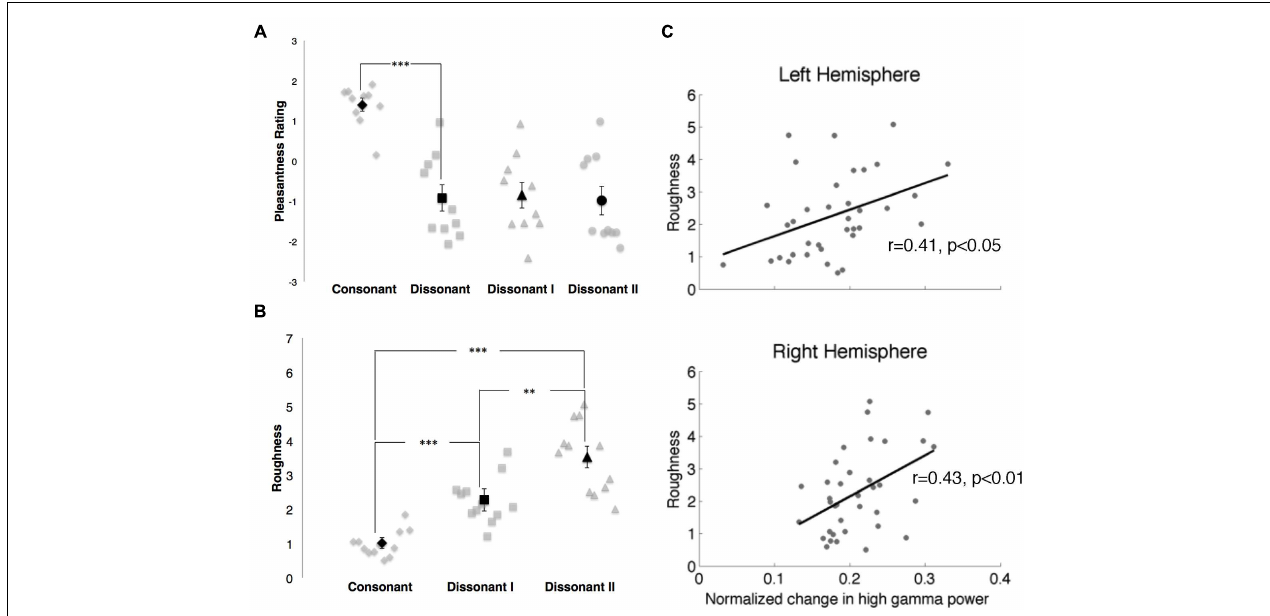
FIGURE 6 | (A) Pleasantness ratings for consonant, dissonant, dissonant I and dissonant II chords as indicated by 10 subjects. Points in gray denote individual subject ratings; points in black denote mean subject ratings. Error bars indicate standard error of the mean ratings. ∗∗∗ p < 0.001 (paired t -test). (B) Roughness measures for consonant, dissonant I and dissonant II chords. Points in gray denote individual chords. Points in black denote mean roughness values. Error bars indicate standard error of the mean roughness value. ∗∗ p < 0.01, ∗∗∗ p < 0.001 (Wilcoxon rank-sum with Bonferroni correction). (C) Correlations between normalized changes in γ high power and stimuli roughness in both hemispheres. Points in gray denote the mean normalized change in γ high power for each chord and its corresponding roughness